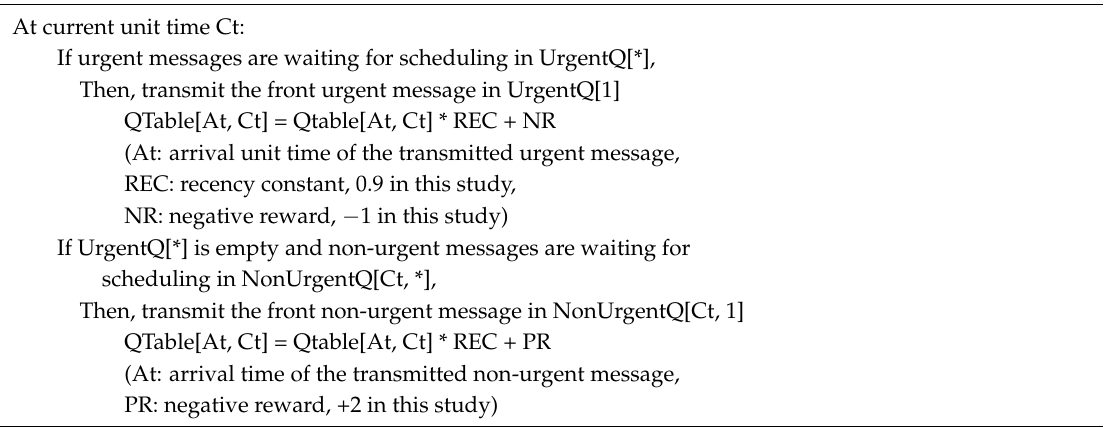
Algorithm 2. Transmission scheduling algorithm for non-urgent messages At current unit time Ct: